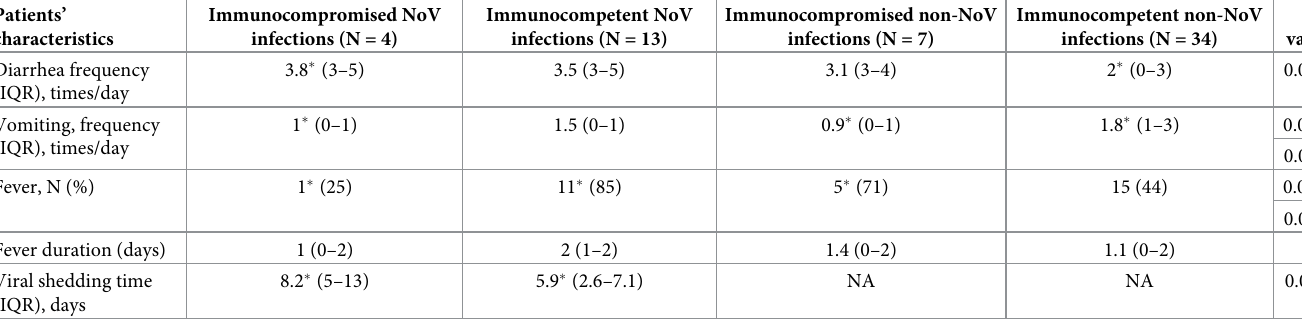
Table 1. Clinical significances of children with or without norovirus infection under different immunity